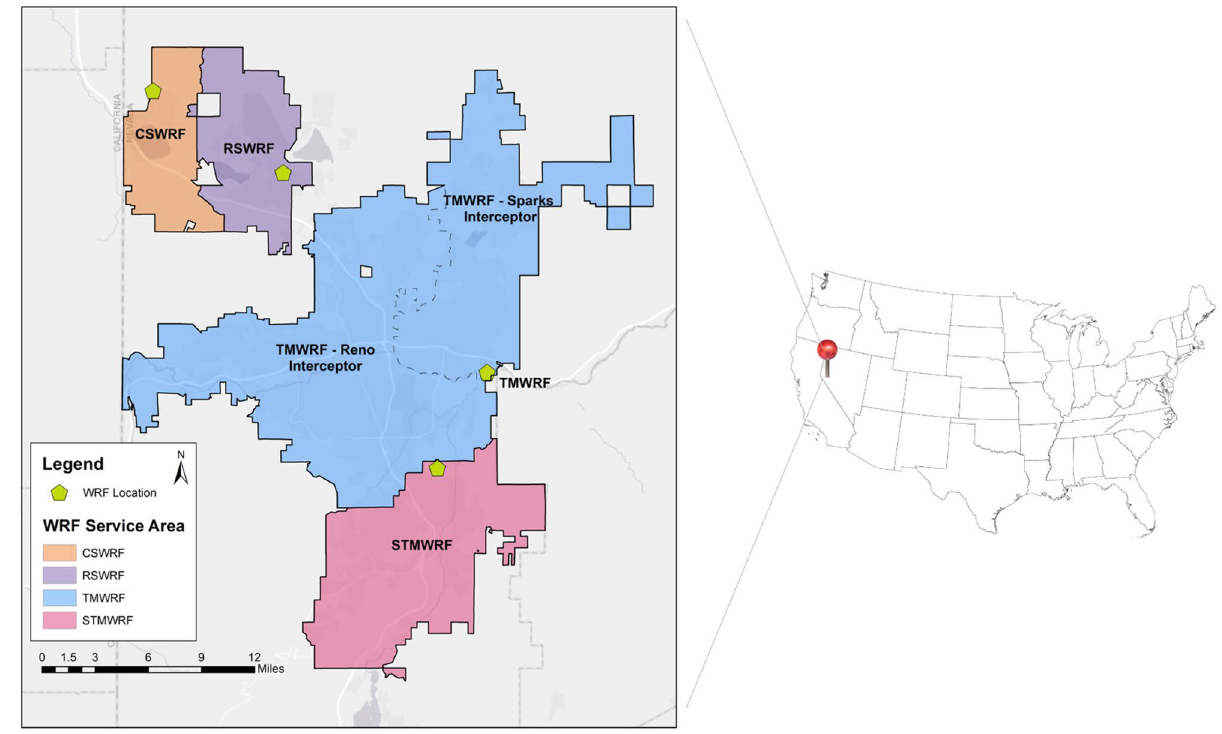
Figure 1. WRF service areas in Washoe County, NV, USA. Sampling occurred at the influent sampling head station of Truckee Meadows WRF (TMWRF), South Truckee Meadows WRF (STMWRF), and Reno-Stead WRF (RSWRF). This map was developed by the authors using ESRI (Environmental Systems Resource Institute; http:// www. esri. com/ softw are/ arcgis) ArcMap Version 10.7.1 with publicly available GIS data from the named